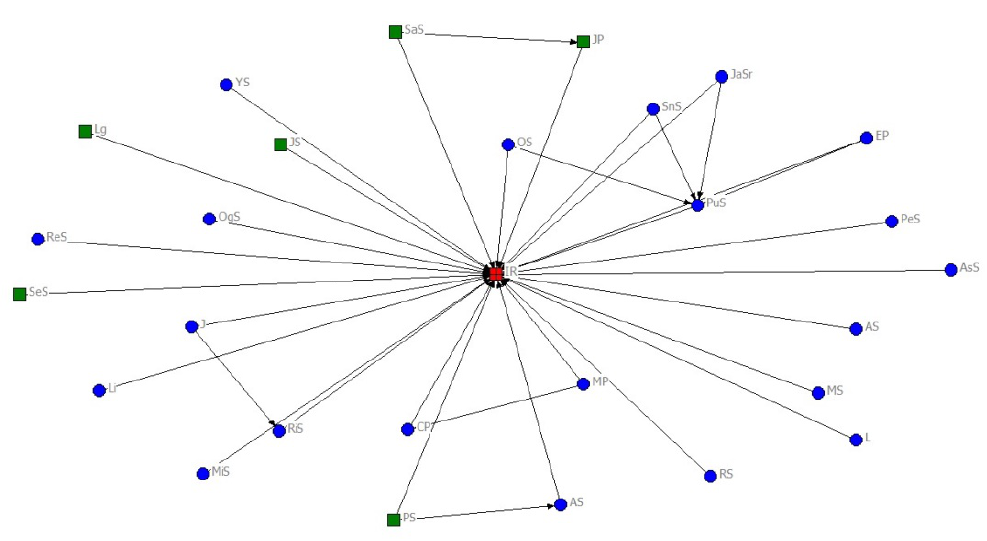
Figure 2: Mapping of Group Social Networks IR